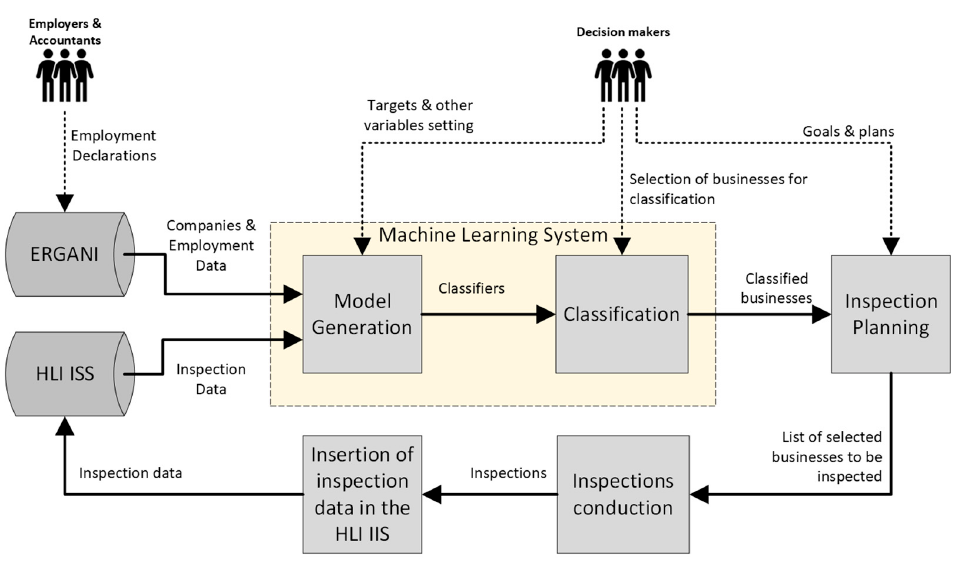
Figure 4. Adaptation of the proposed methodology in the business environment of a labour inspec- torate.